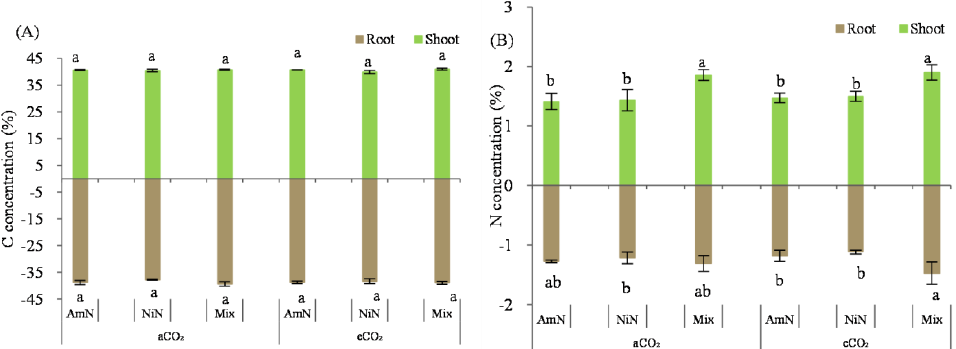
Figure 7. The total carbon ( A ) and total nitrogen ( B ) concentration in maize seedlings. Note: (1) AmN denotes Ammonium N, NiN denotes Nitrate N, Mix denotes Mixed N; (2) TC means total C concentration, TN means total N concentration; (3) aCO 2 denotes the ambient atmospheric CO 2 concentration at 390 µmol/mol; eCO 2 denotes the enriched atmospheric CO 2 concentration at 690 µmol/mol; (4) Different letters mean significant differences at p < 0.05 level for each indice; (5) error bars are the standard deviation; (6) above− and belowground LSD are separate analyses.